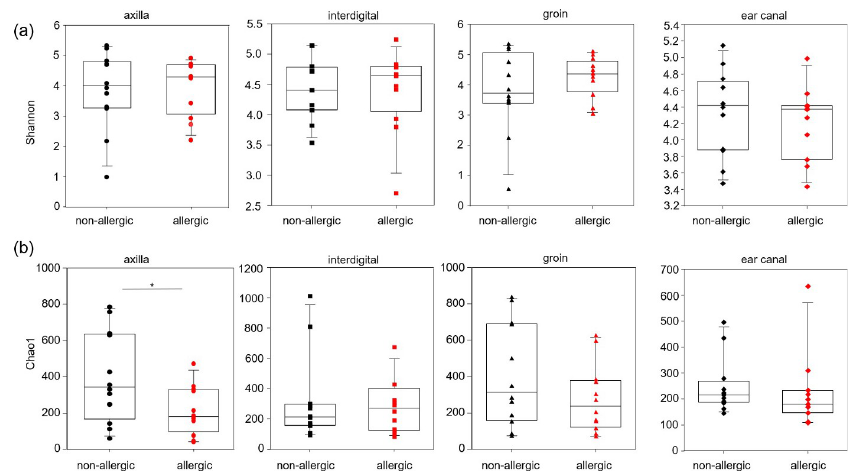
Fig 5. Box-plots of the alpha diversity indexes Shannon (total diversity) (a) and Chao1 (b) of the skin microbiota per body site (axilla, interdigital, groin, ear canal) of non-allergic and allergic German shepherd dogs, based on Illumina 16S rRNA gene amplicon sequencing of microbial communities. Asterisks are representing statistical significance: � p < 0.05.